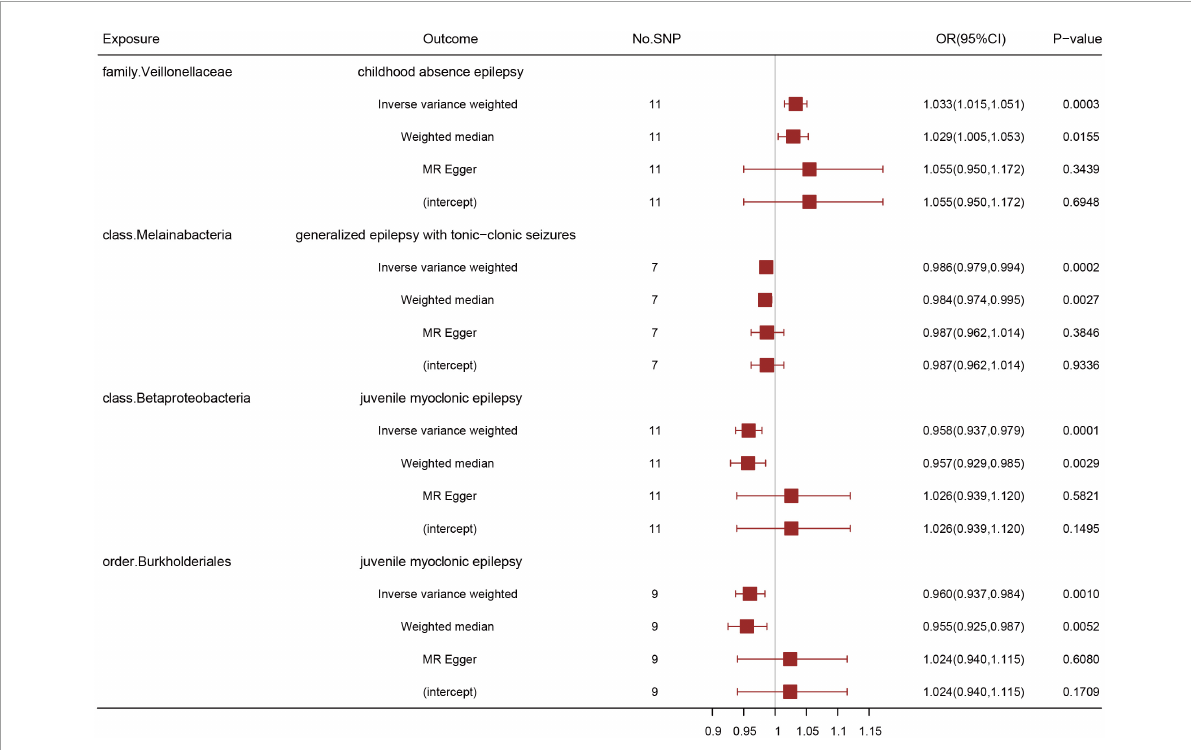
FIGURE3 Association of genetically predicted gut microbiota with epilepsy by three different MR methods: inverse variance weighted, weighted median, and MR Egger. A positive correlation between the family Veillonellaceae and childhood absence epilepsy, negative correlations between the class Melainabacteria and generalized epilepsy with tonic-clonic seizures, between the class Betaproteobacteria and juvenile myoclonic epilepsy, and between the order Burkholderials and juvenile myoclonic epilepsy were suggested. OR: odds ratio; CI: confidential